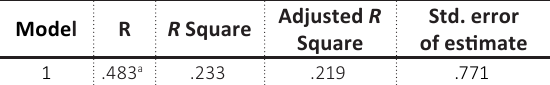
Table 3. Regression analysis, R 2 statistics (leadership styles and work engagement)